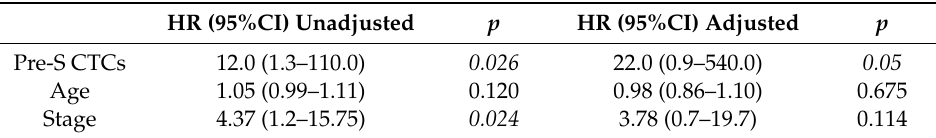
Table 2. CTC number in pre-surgery blood samples is the best predictor of death risk in ACC patients. Univariate (unadjusted) and multivariate (adjusted) Cox regression analysis of the risk of death hazard ratio (HR) (95%confidence interval, CI) in univariate and multivariate model for the indicated parameters. Significant p values are indicated in